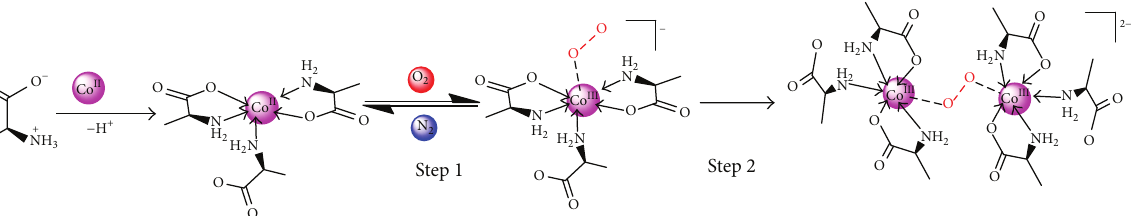
Figure 3: Formation and oxygenation of the Ala–Co complex.